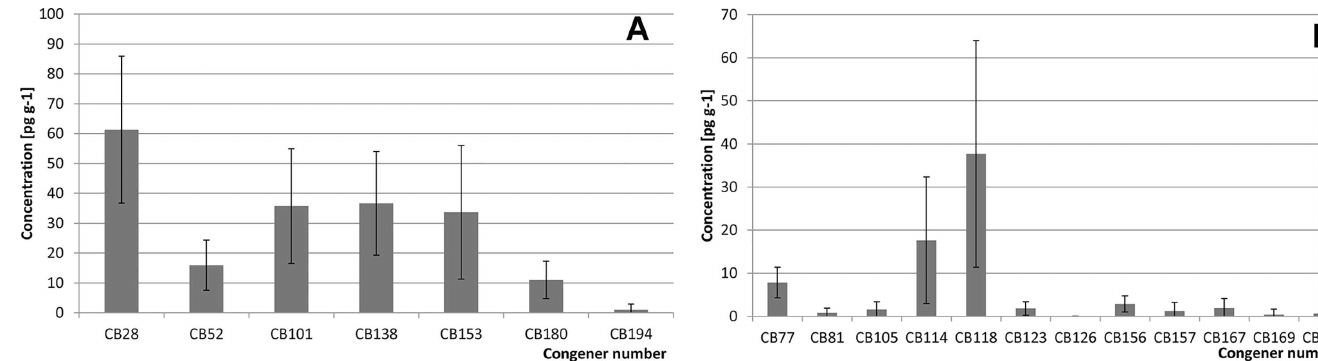
Fig 3. Indicator (A) and dioxin-like(B) chlorinatedbiphenyls profiles observedin the analyzedpollensamples.